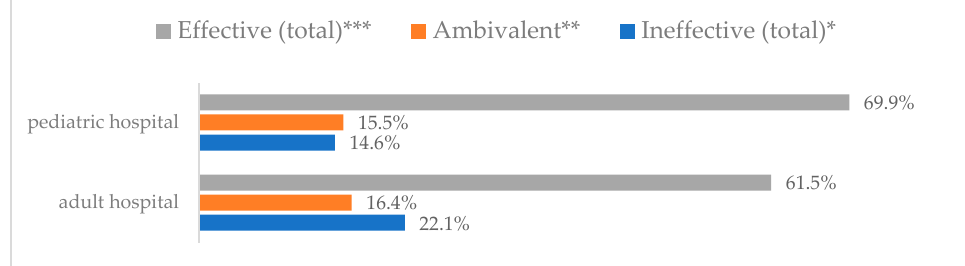
Figure 3. Wearing a protective mask that covers the mouth and nose to prevent influenza virus infection by type of hospital ( N = 905). *Sum of responses: completely ineffective, ineffective, rather ineffective; **Response: neither ineffective nor effective; ***Sum of responses: rather effective, effec- tive, completely effective.